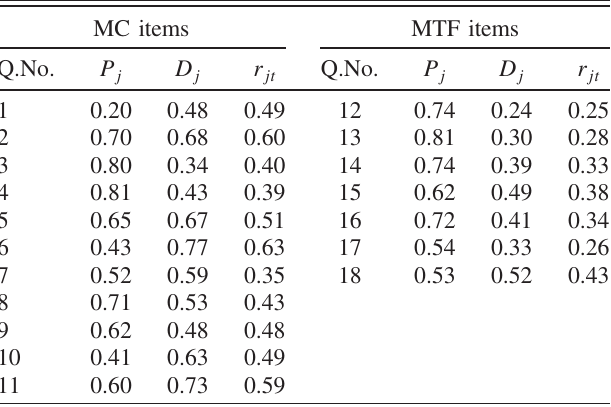
TABLE III. KiRC inventory pretest item statistics: item difficulty index ( P ), item discriminatory index D j test-correlation ( r ) for each item j . For each MTF cluster (items jt 12 – 18), statistics were averaged.